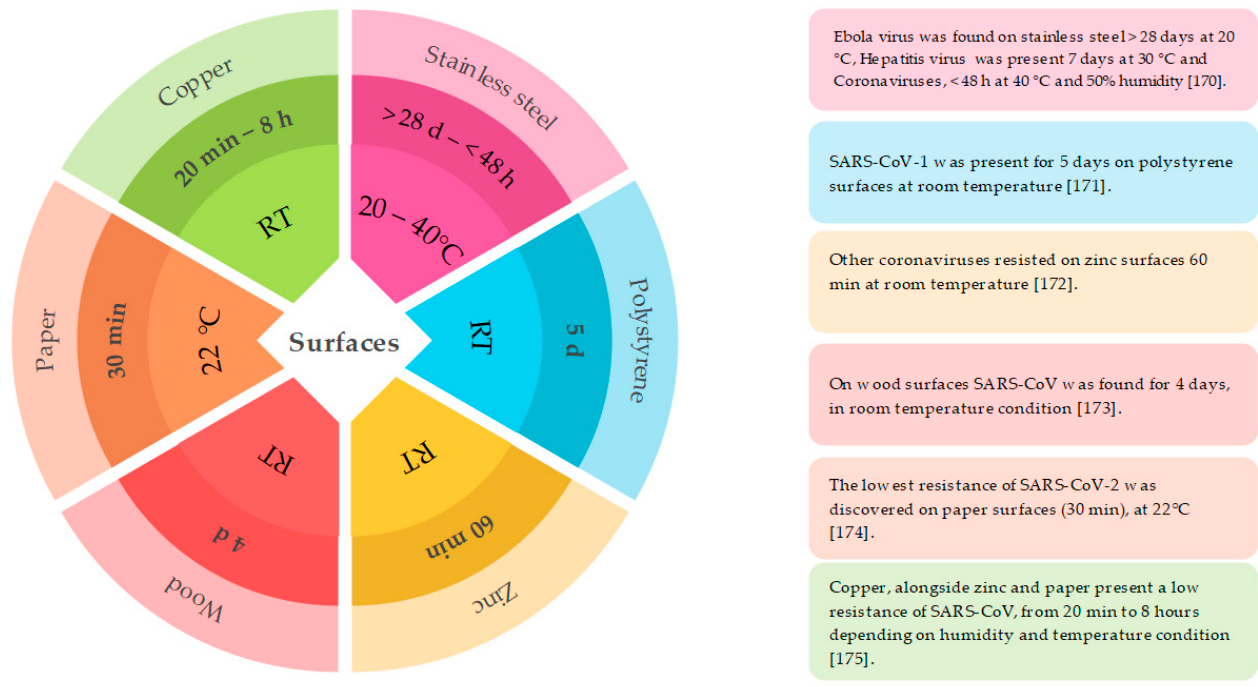
Figure 4. Capacity of SARS-CoV-2 and other viruses to persist on the package surfaces. RT, room temperature: 20–26 °C [170–175].